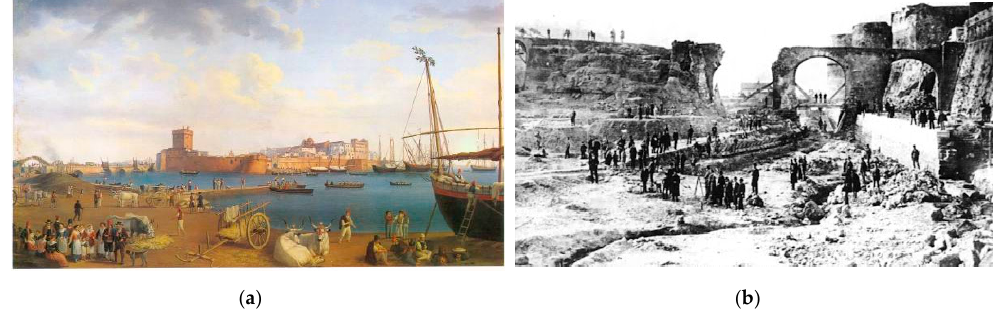
Figure 4. Ancient views of the city of Taranto: ( a ) view of the port in a 1789 print and ( b ) demolition of the castle towers and construction of the navigable canal.